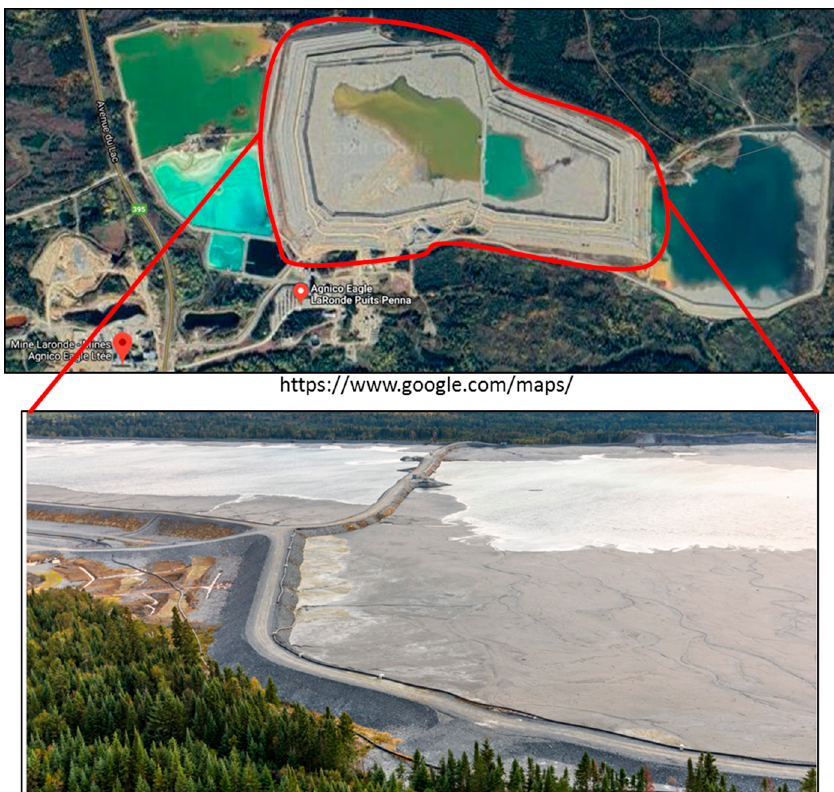
Figure 1. LaRonde tailings storage facility.